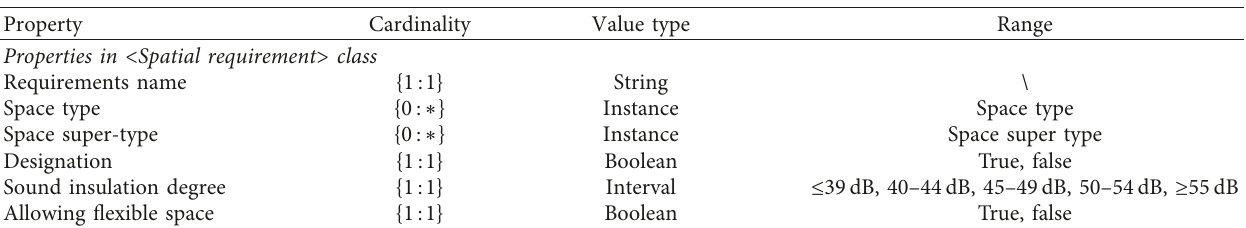
Figure 2: Ontologies representing user activities and space in space-use analysis. Table 1: Properties and Facets of the < Spatial requirement > , < Whole room use requirement > , and < Equipment use requirement > classes.